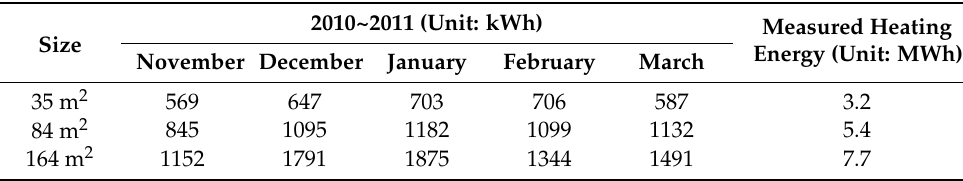
Table 4. Measured annual heating energy consumption according to the growth in household size in 2010.